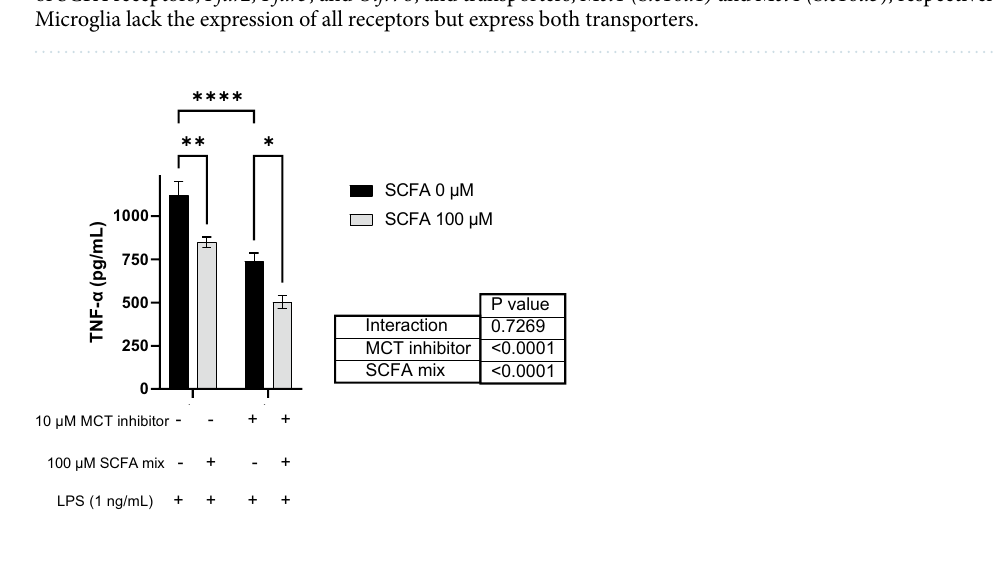
Figure 7. Effect of monocarboxylate transporters (MCT) blockade on short-chain fatty acids activity in primary microglia after LPS stimulation. Cells were pre-treated with SCFA mix (0 or 100 µM) for 4 h, and then stimulated with LPS (1 ng/mL) for 4 h. Samples were analyzed 2-way ANOVA (2 × 2 factorial arrangement of MCT inhibitor x SCFA mix), followed by Tukey’s multiple comparisons test. * P < 0.05, ** P < 0.01, *** P < 0.001, and **** P <